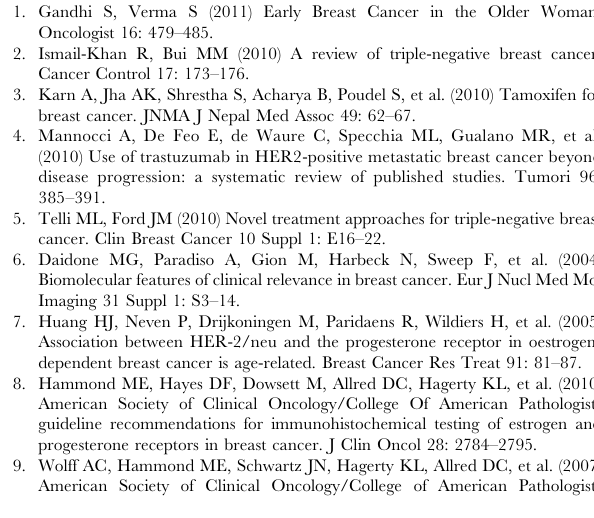
Table S1 Gene signature predictive of ER status. Because the gene signature contains only genes with positive Spearman correlation coefficients there is no division based on the coefficients. Genes were sorted alphabetically by their symbol. (XLS) Table S2 Gene signature predictive of ERBB2 status. The list of genes is divided into those with positive and negative correlation coefficients. Genes were sorted alphabetically by their symbol. (XLS) Table S3 Gene signature predictive of PR status. The list of genes is divided into genes with positive and negative correlation coefficients. Genes were sorted alphabetically by their symbol. (XLS) Table S4 Hormone and ERBB2 receptors status deter- mination: sensitivity (‘ + ’) and specificity (‘-’) obtained with two different microarray-based methods. ‘‘One probe set’’-by using the single probe set described in the literature. ‘‘Signature’’-by using our predictive signature. Figure 7. Algorithm for finding the gene signatures predictive